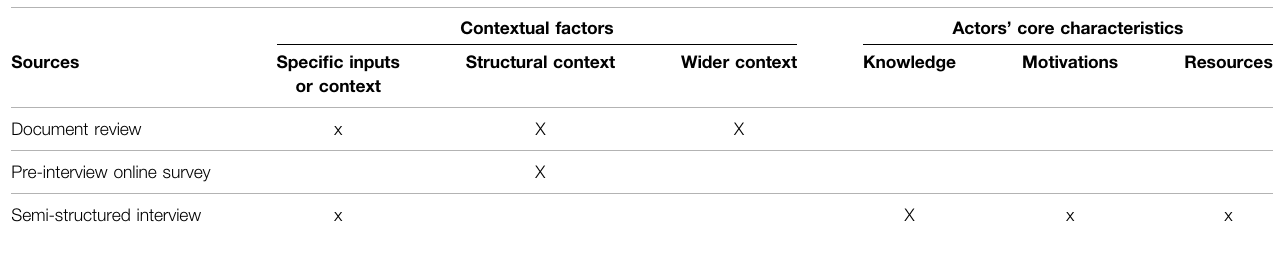
TABLE 1 | Sources of evidence for the